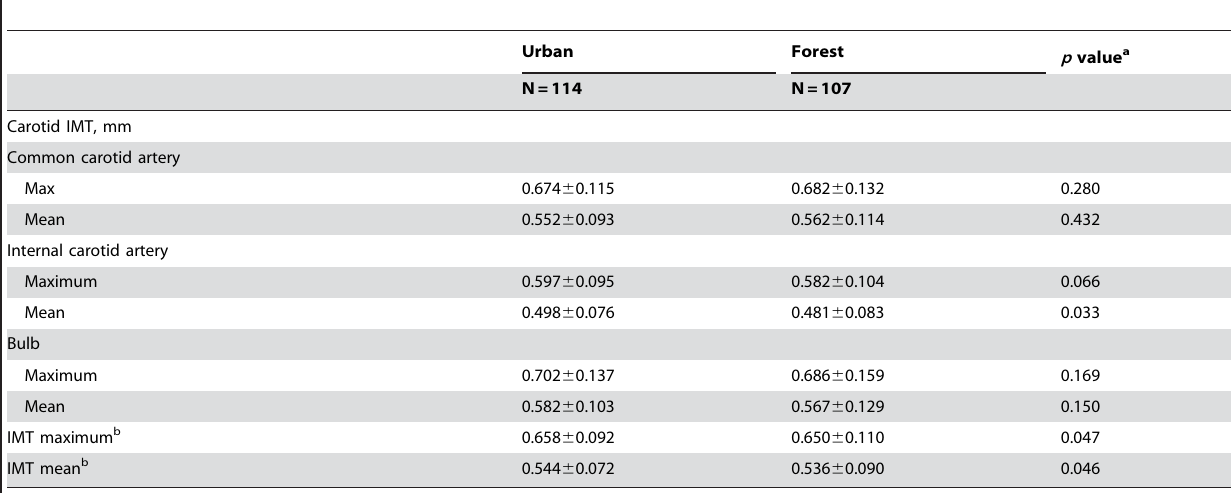
Table 6. Carotid intima-media thickness (IMT) of the urban and forest staff member groups.